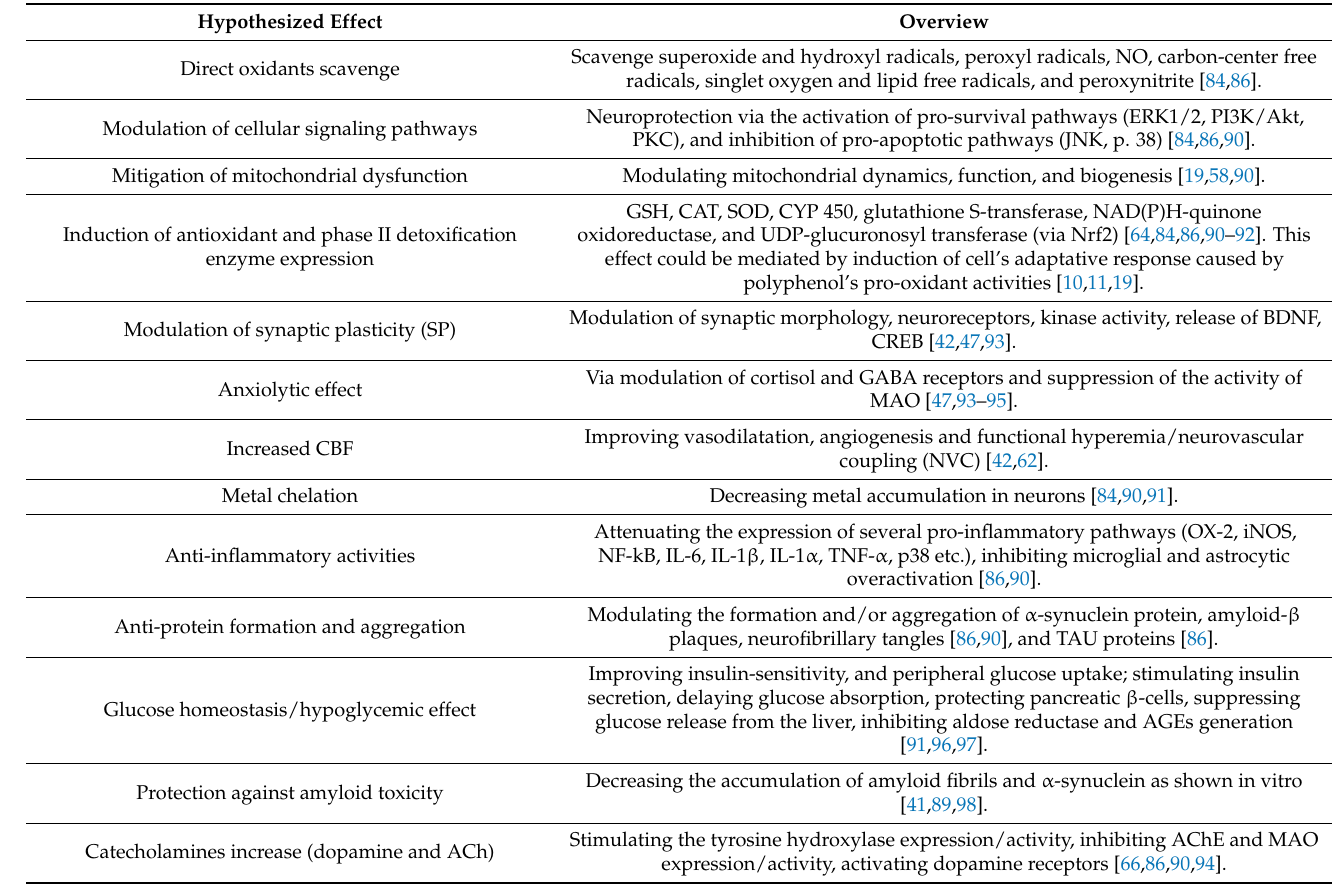
Table 4. Polyphenols and neuroprotection: hypothesized pathways